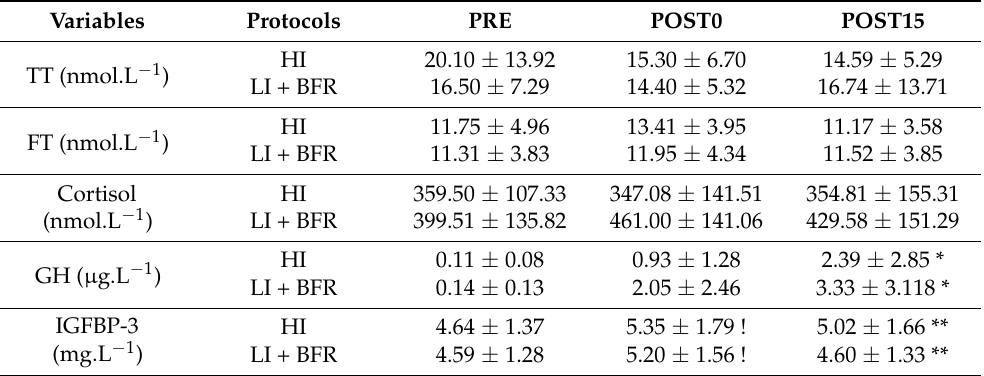
Table 2. Serum hormone concentrations (mean ± standard deviation) in the two protocols before (PRE), immediately after (POST0), and 15 min post-exercise (POST15). Variables Protocols